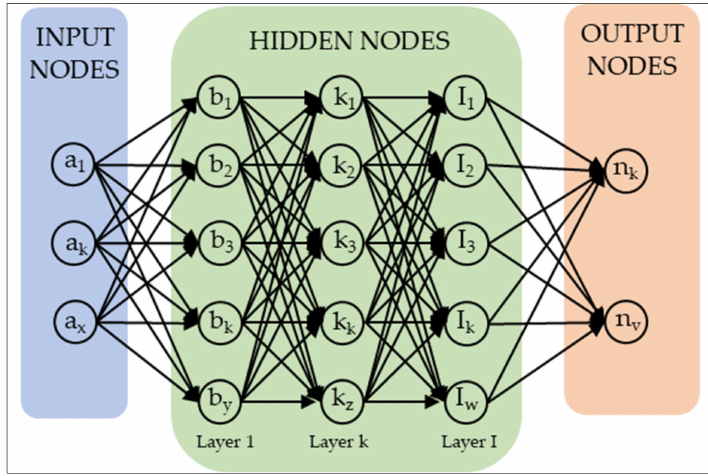
Figure 7. The framework of DL model (reproduced from